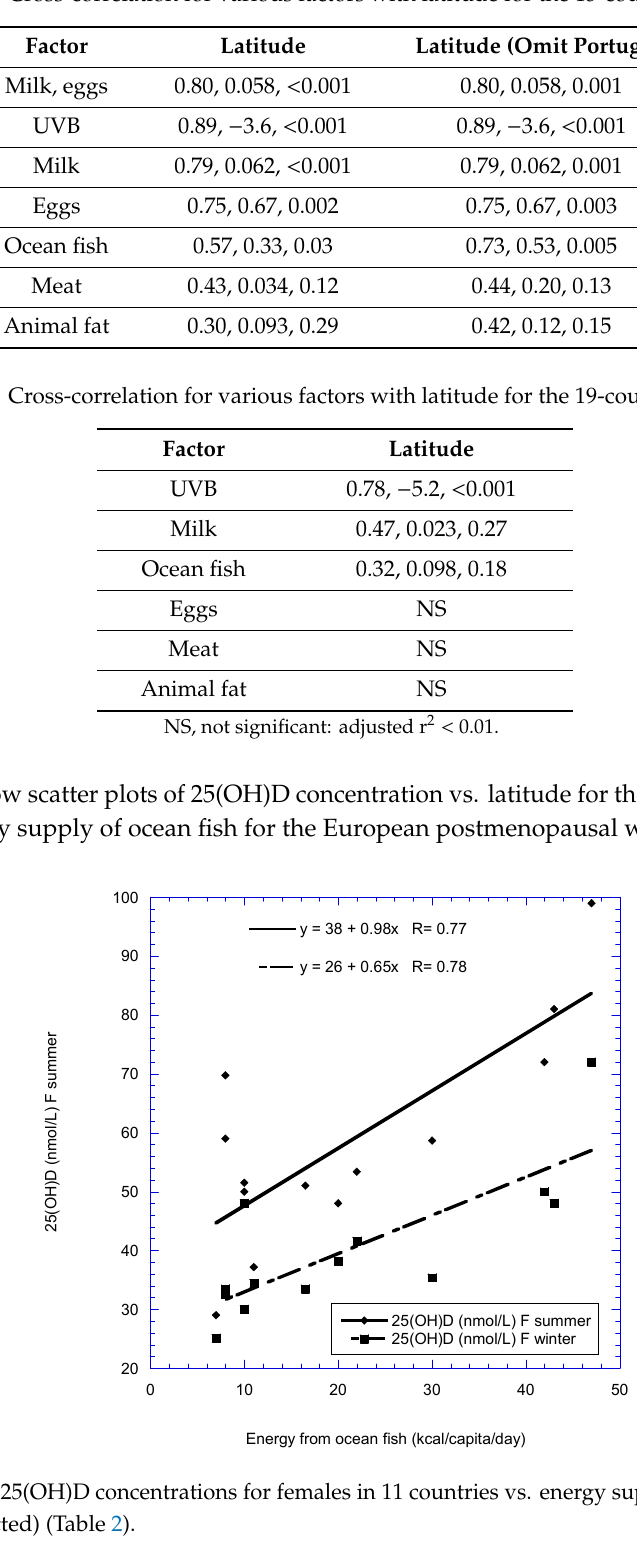
Table 6. Cross-correlation for various factors with latitude for the 15-country study.